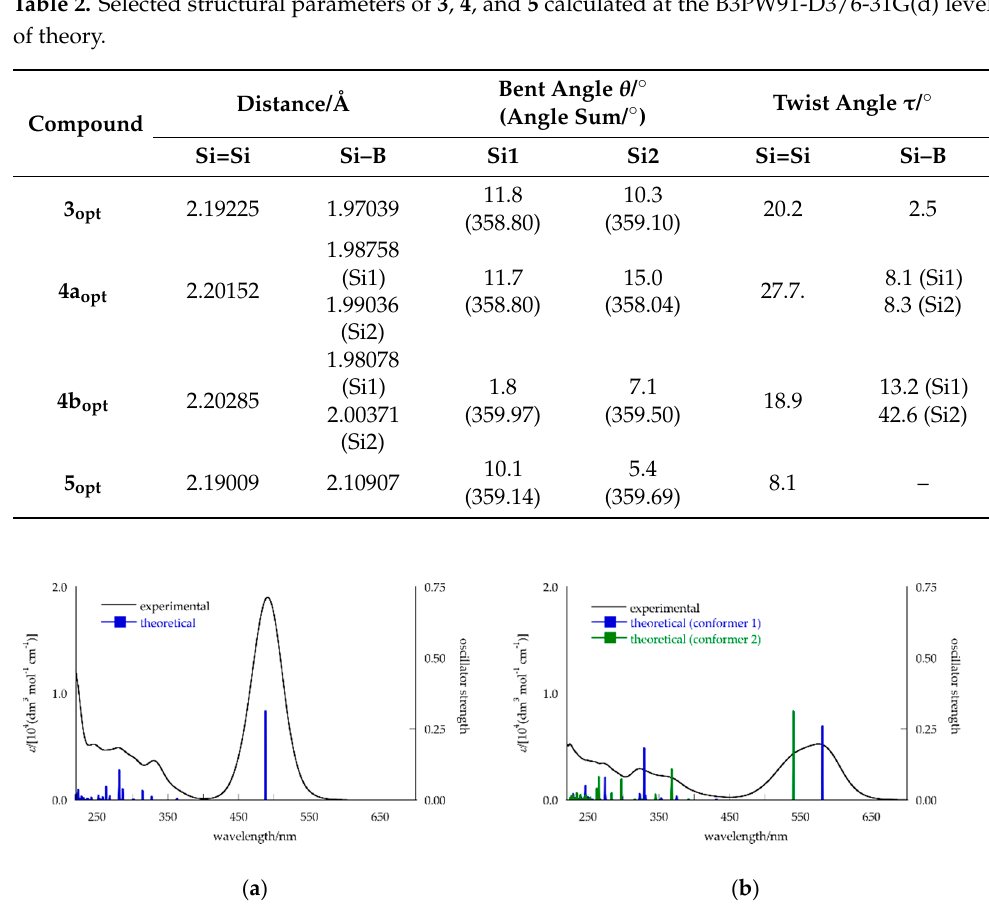
Figure 4. UV-vis spectra in hexane at room temperature and theoretical band positions and oscillator strengths (vertical bars) calculated at the B3LYP-D3/B1(hexane)//B3PW91-D3/6-31G(d) level of theory (B1: 6-311G(2df) [Si], 6-311G(d) [N, C, B, H]). ( a ) Compound 3 and ( b ) compound 4 .